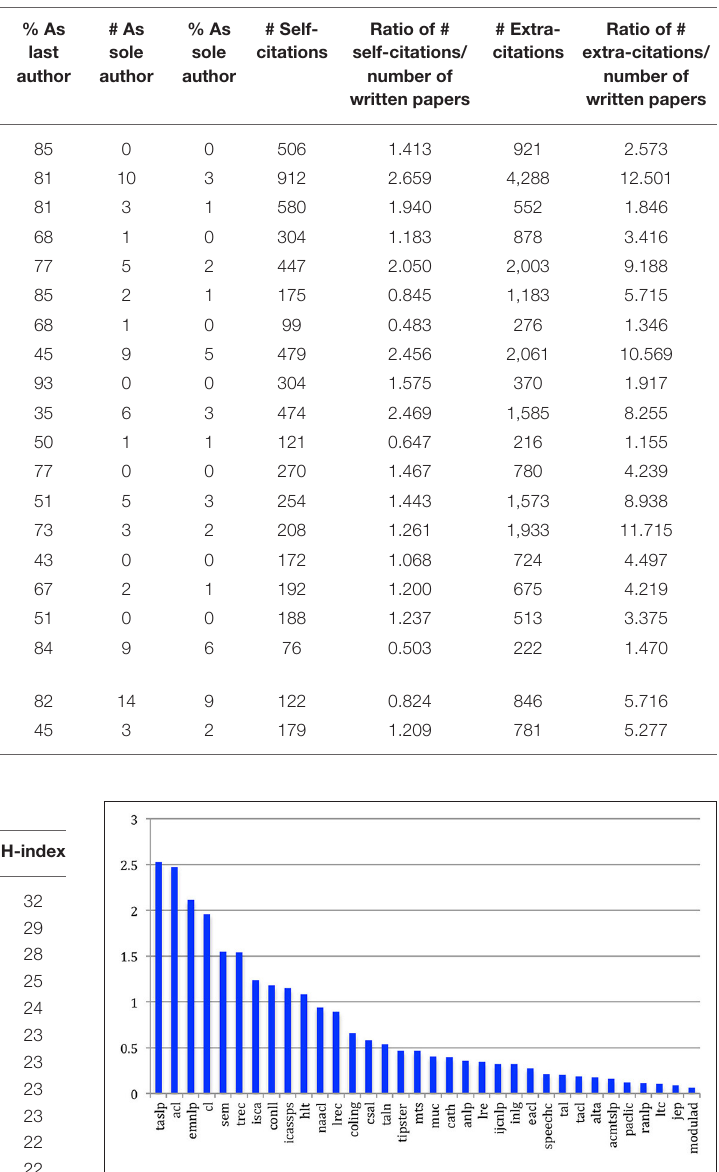
TABLE 11 | Number of citations for the 20 most productive authors.